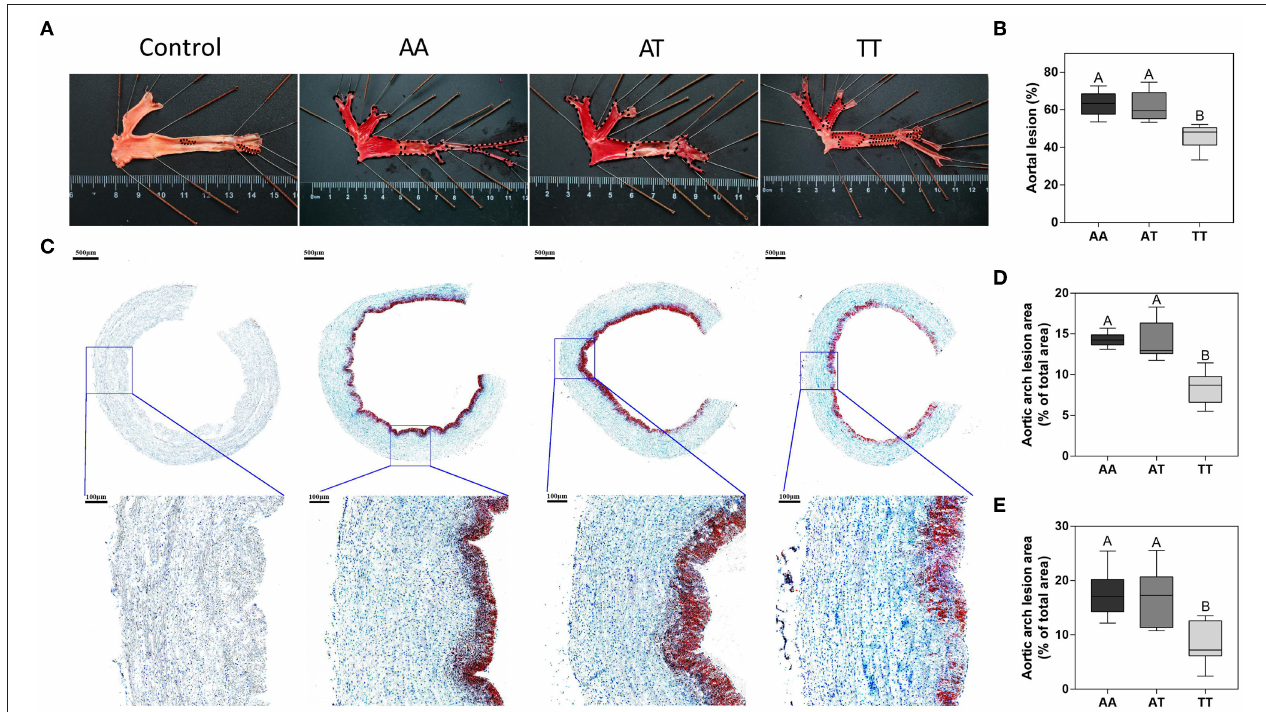
FIGURE 1 | Pathological observations of lipid deposition in the aortic wall in different genotyped layers. (A) Oil Red O staining of the whole aorta with aortic lesions (black dashed lines). (B) Quantification of staining results (% of the total area) of the aorta. (C) Oil Red O and hematoxylin staining of aortic arch cross-sections with local tissue magnification (blue squares). Quantification of staining results (% of the total area) of the aortic arch cross-section (D) and its local tissue magnification (blue squares) (E) . (B,D,E) Box plot lower extreme is first quartile; box plot upper extreme is third quartile. AA, AA genotype hens; AT, AT genotype hens; TT, TT genotype hens. n = 9 hens with each genotype. A,B Means within a histogram with no common superscripts differ significantly ( P <